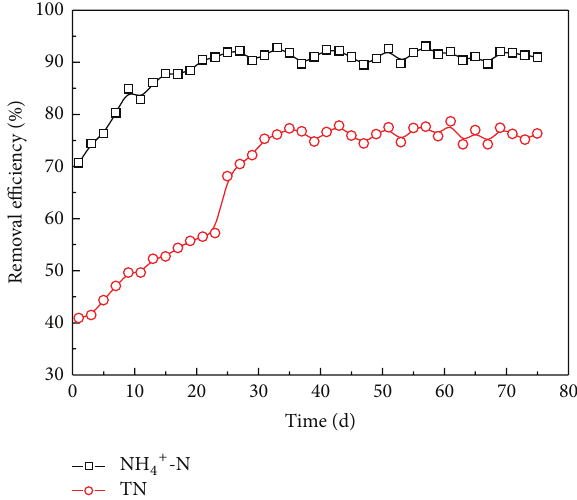
Figure 3: Profiles of different nitrogen concentrations in the startup and steady run periods.